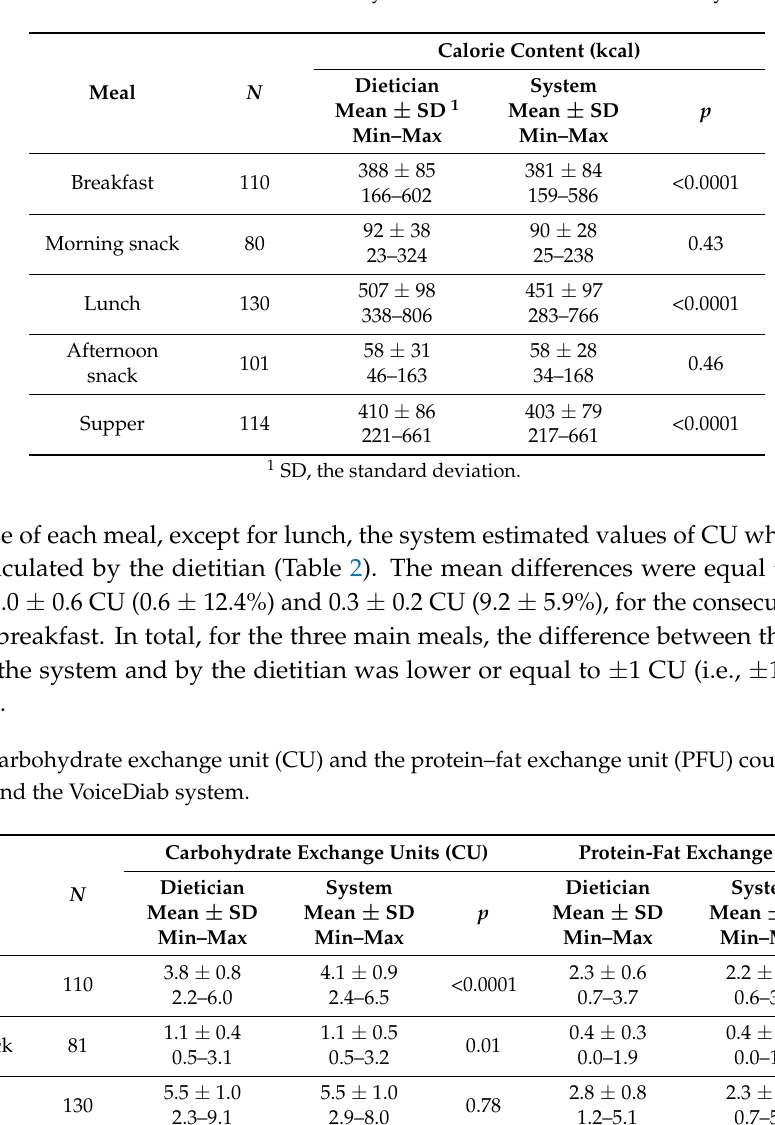
Table 1. Calorie content estimated by the dietician and the VoiceDiab system.